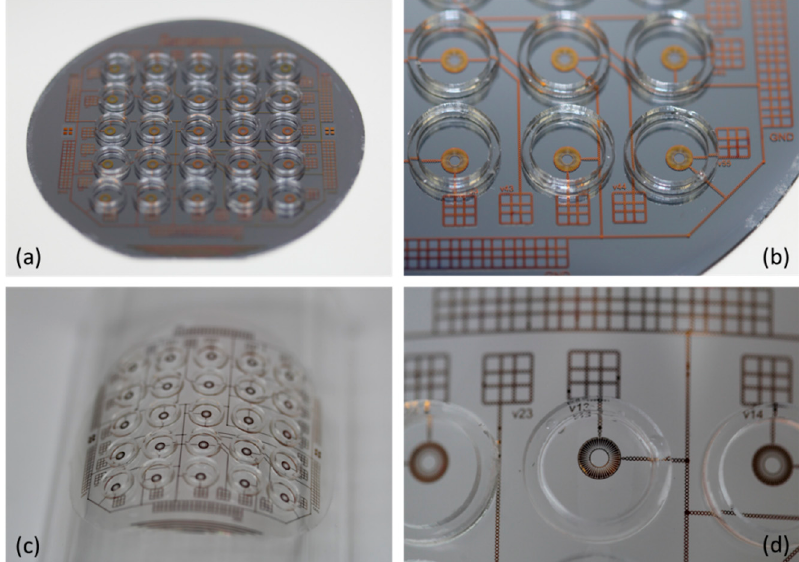
Figure 3. Photographs of ( a ) a 5 × 5 electrowetting on dielectric (EWOD) tunable lens array while still on a silicon carrier wafer used to ease the fabrication process, ( b ) a closer view of the lenses and contact pads of the array, ( c ) the PDMS sheet wrapped around a cylinder of a radius r = 70 mm, ( d ) a close-up view of a single, filled liquid lens in the